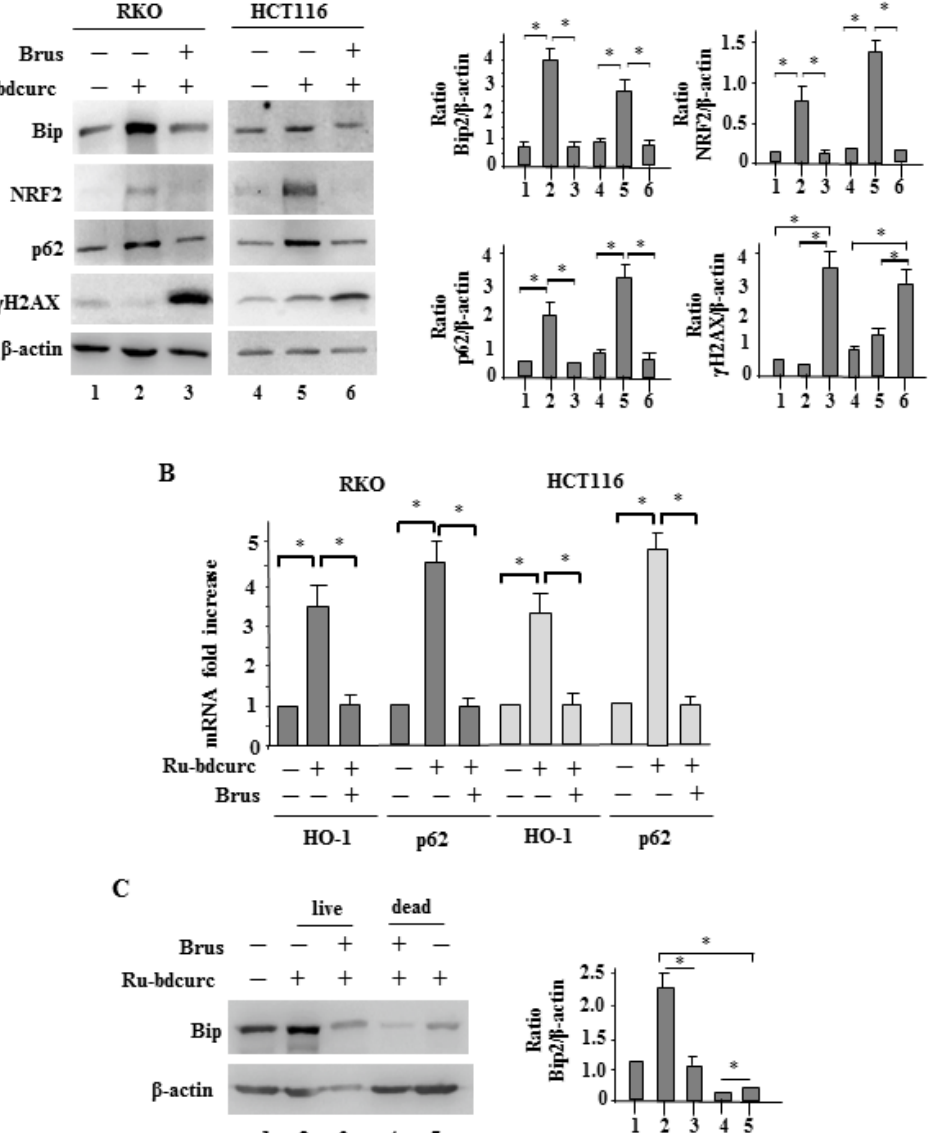
Figure 4. Inhibition of NRF2 reduced BiP and induced DNA damage in response to Ru-bdcurc. ( A ) Western blot analysis of the indicated proteins in RKO and HCT116 colon cancer cells pre-treated with 100 brusatol (Brus) for 4 h and the treated with 100 µ M Ru-bdcurc for 24 h. β -actin was used as protein loading control. The ratio of the proteins level vs. β -actin, following densitometric analysis, is reported in the right panels. ( B ) Total mRNA was extracted from cells treated as in ( A ) to evaluate HO-1 and p62 gene expression by RT-PCR of reverse transcribed cDNA. Histograms represent the mean of three independent experiments ± S.D. ( C ) RKO and HCT116 cells were pre-treated with 100 brusatol (Brus) for 4 h and then treated with 100 µ M Ru-bdcurc for 48 h. After treatment, the expression of BiP in living or dead cells was evaluated by Western blot analysis. β -actin was used as protein loading control. The ratio of BiP level vs. β -actin, following densitometric analysis, is reported in the right panel. * p ≤